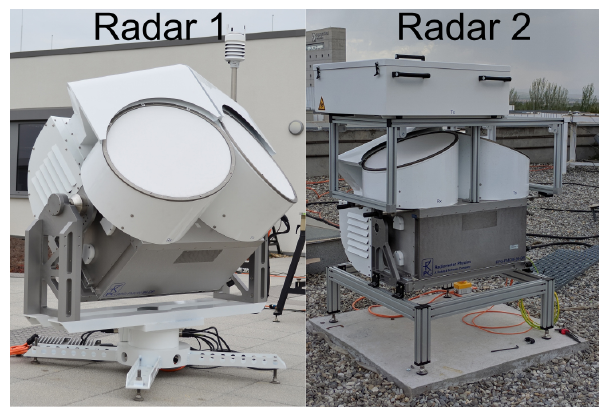
Figure 1. Impressions of the two frequency-modulated continuous wave (FMCW) W-band radars used in this study, as indicated in Table 2. Images courtesy of the radar